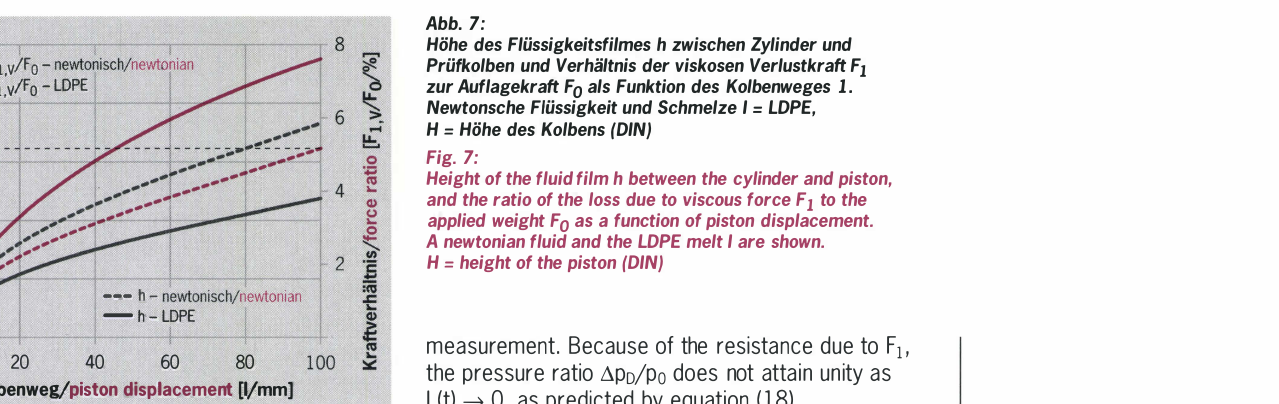
measurement. Because of the resistance due to F1, the pressure ratio i'lPo/Po does not attain unity as L(t) 0, as predicted by equation -7